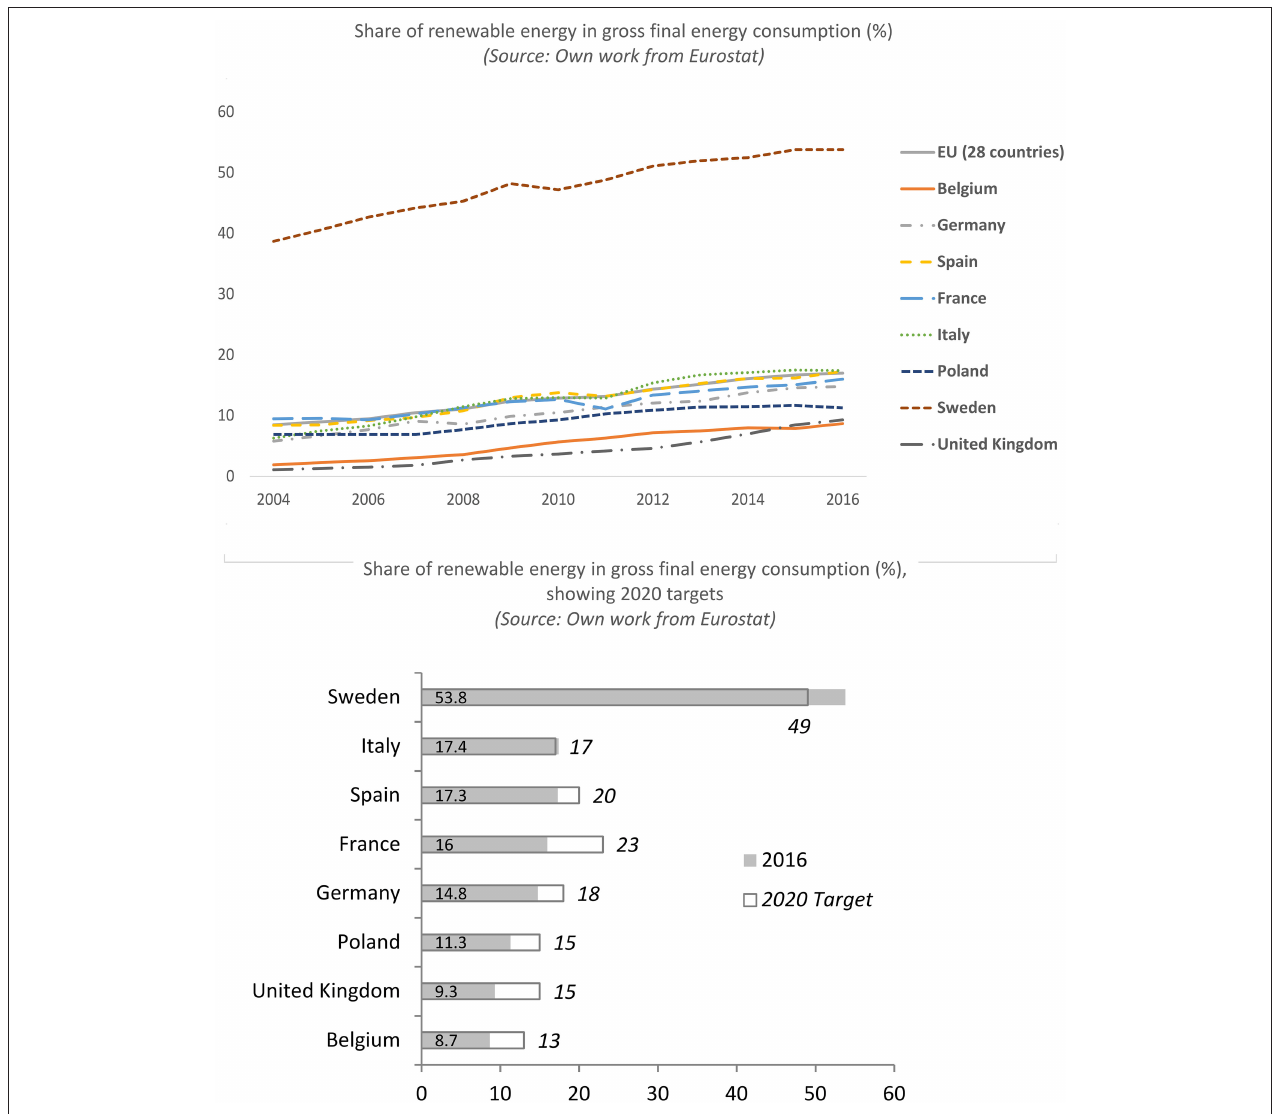
FIGURE 1 | Renewable energy as a percentage of total final energy (Top) and 2020 targets (Bottom).